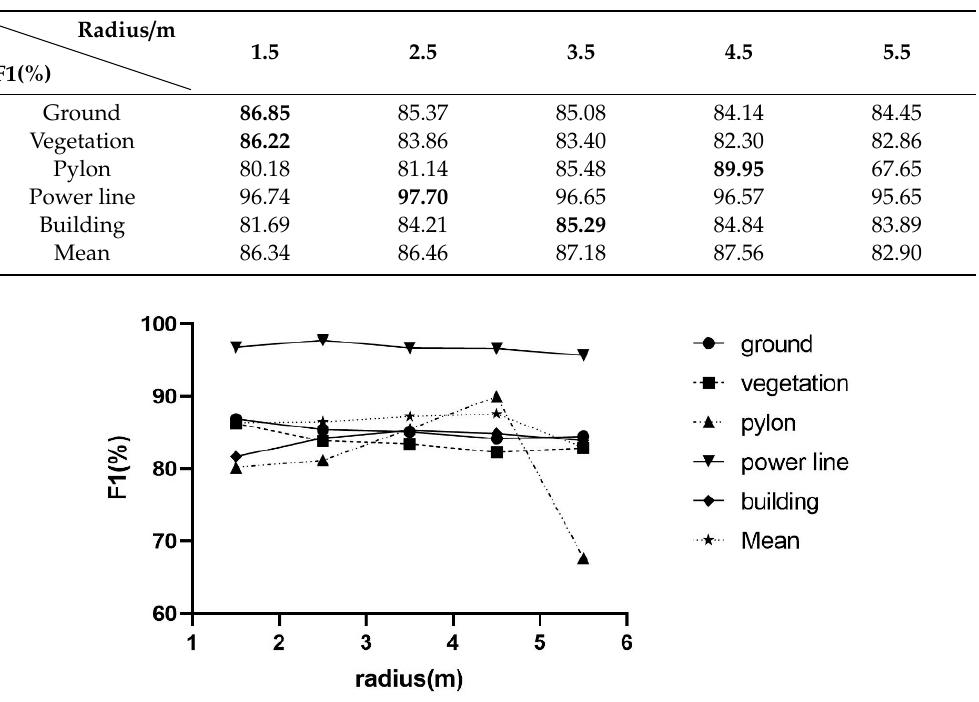
Table 13. The sensitivity analysis of neighborhood radius for feature extraction about each class (classifier = RF, class distribution = unbalanced, test set = site III). Bold denotes best results for each class.